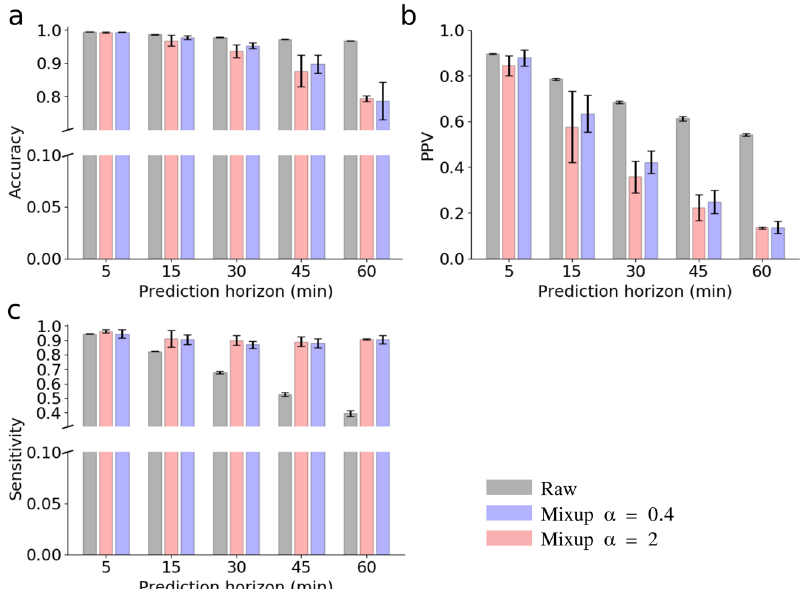
Fig. 7 Sensitivity analysis of the prediction horizon on three predictive scores with twofold mixup data augmentation on minority training data. We compare the performance of our CNN model trained on the raw training dataset and on the training dataset augmented by two mixup models, one with α = 0.4 and the other with α = 2 for the Beta distribution Beta( α , α ) implemented in mixup. The performance of each model is calibrated in terms of a prediction accuracy, b positive predictive value (PPV, the precision of the positive class), and c sensitivity (recall of the positive class). A table for the detailed numerical results is shown in Supplementary Table 6. Hypoglycemia (the minority class, also the positive class) samples in the training data is augmented with twofold mixup. The purple-shaded bars denote the predictive scores by mixup ( α = 0.4), the red-shaded bars denote those by mixup ( α = 2), and the gray-shaded bars denote those by the raw training data (no data augmentation). Error bars (standard deviation, s.d.) are computed over all patients ’ results. Table 2. Baseline characteristics of the study participants and an overview of the blood glucose data. Normally distributed variables are presented in mean ± standard deviation form, otherwise as median ( fi rst quartile, third quartile) and mean ± standard deviation